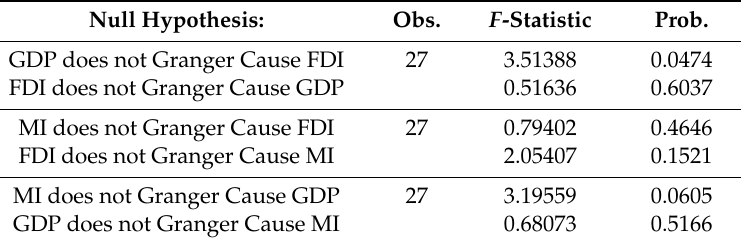
Table 7. Pairwise Granger causality Table 6. Pairwise Granger causality tests.